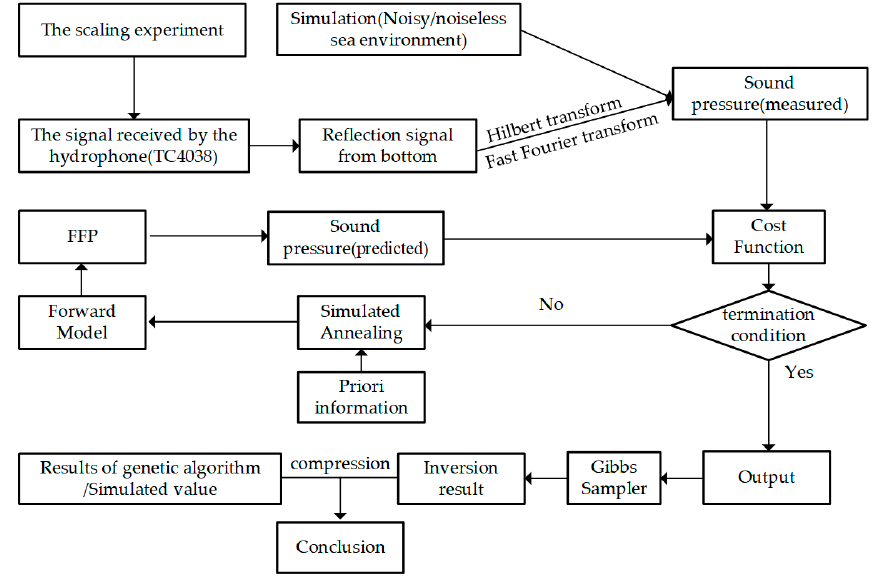
Figure 3. The diagram of the